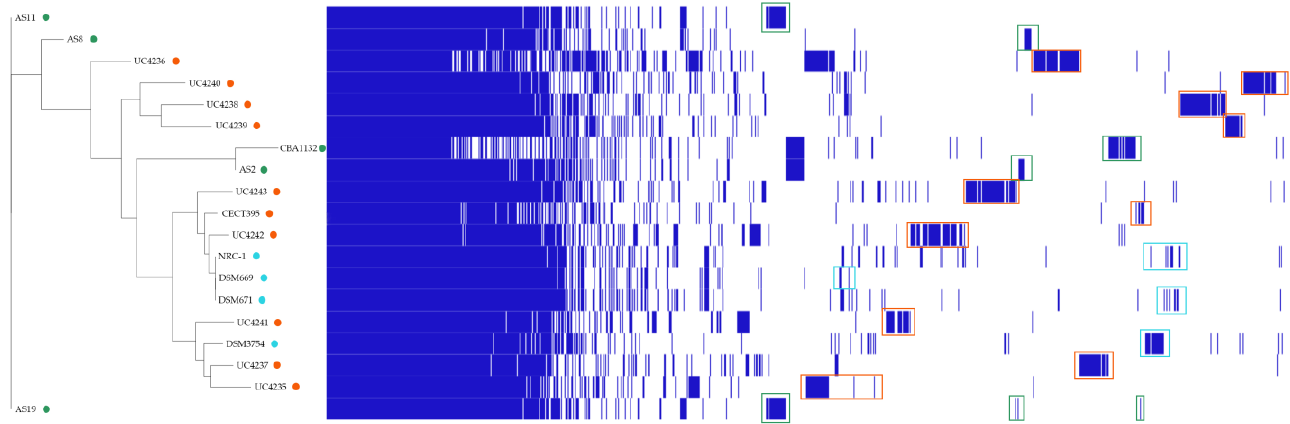
Figure 2. Phylogenetic tree based on the core gene alignment and the gene presence/absence matrix of the investigated strains. Orange, cyan, and green circles represent food, animal, and environmental H. salinarum strains, respectively. Orange, cyan, and green rectangles indicate unique gene clusters of each strain in relation to the isolation category.